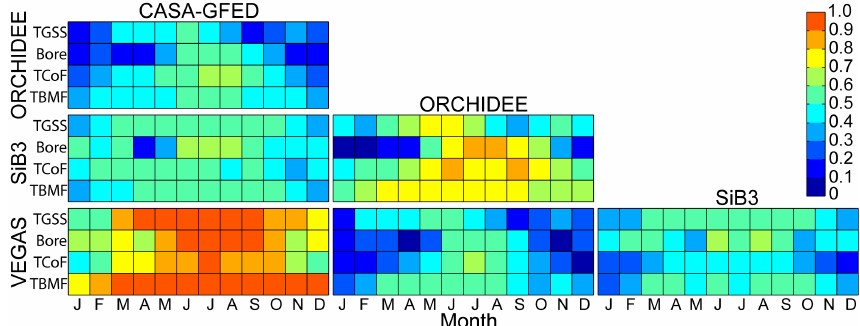
Figure 6. The correlation coefficient of NEE spatiotemporal series as simulated by different TBMs throughout 2008 for the four biomes better constrained by available atmospheric observations. TGSS: Temperate Grasslands, Savannas, Shrublands; Bore: Boreal Forests and Taiga; TCoF: Temperate Coniferous Forests; TBMF: Temperate Broadleaf and Mixed